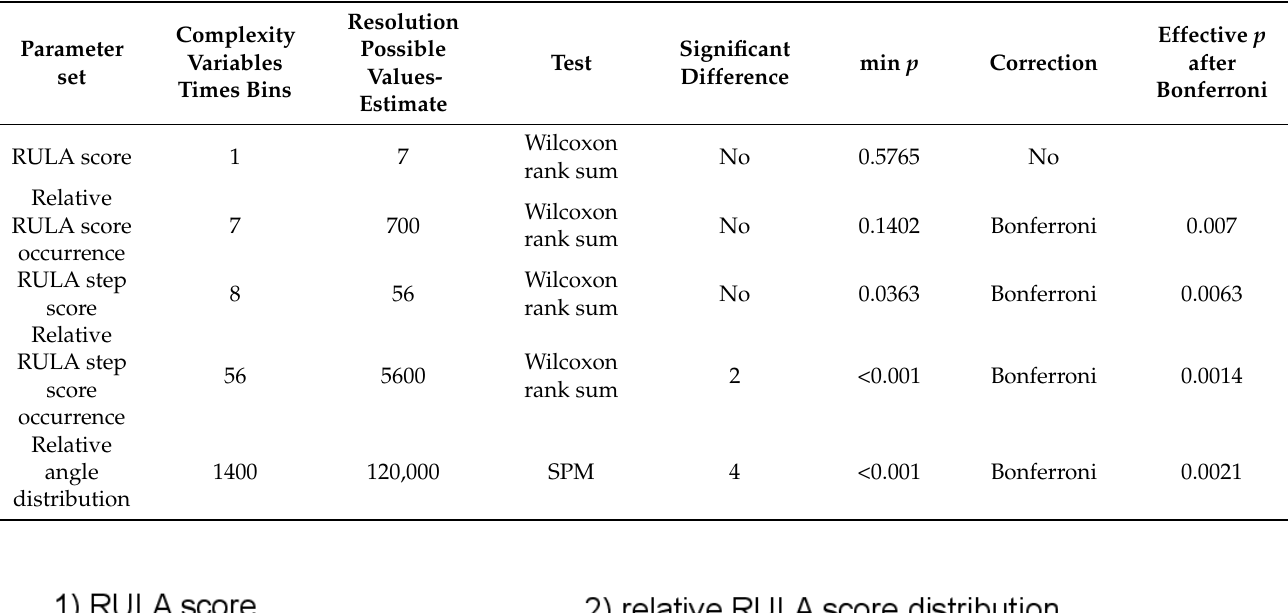
Table 2. Summary of the five levels of complexity. The complexity versus the resolution is also plotted in Figure 4. The complexity is calculated based on the number of variables or the number of variables times bins (whatever is applicable). The resolution is estimated based on the number of possible values. Test statistic was applied, and number of significant findings were carried out. min p : the maximal significance that was found.